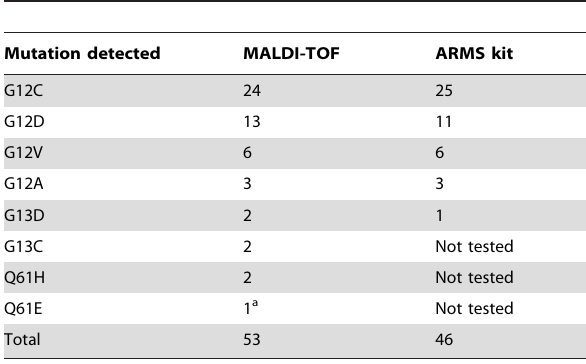
Table 2. Comparison of number of individual KRAS mutations detected by MALDI-TOF and ARMS kit.